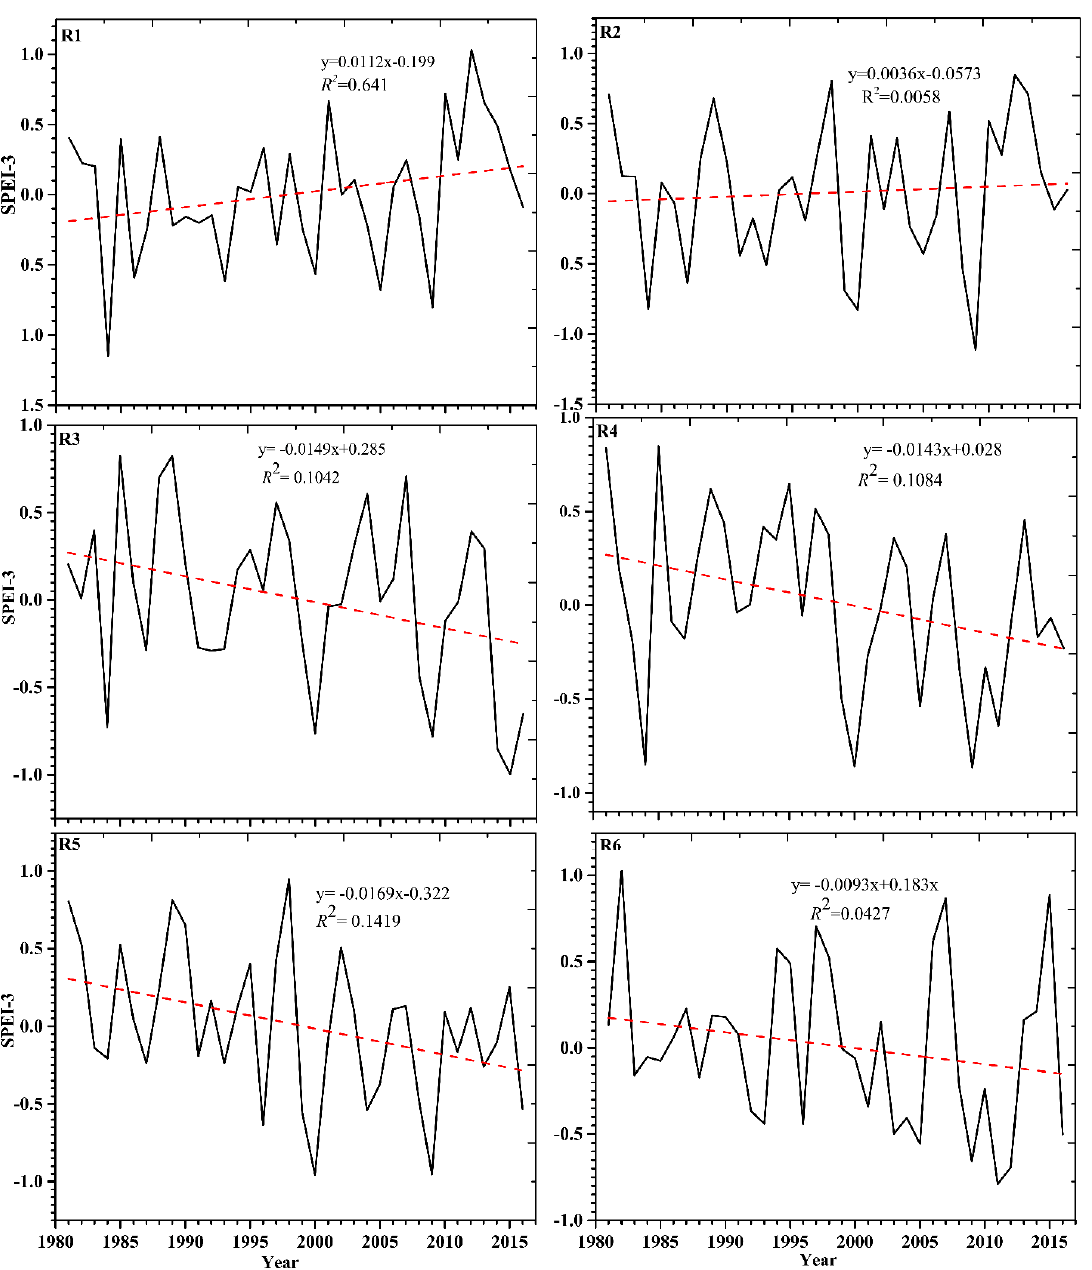
Figure 4. Linear trends of dry and wet events for SPEI-3 over six distinct climatic zones, as presented in Figure 1.